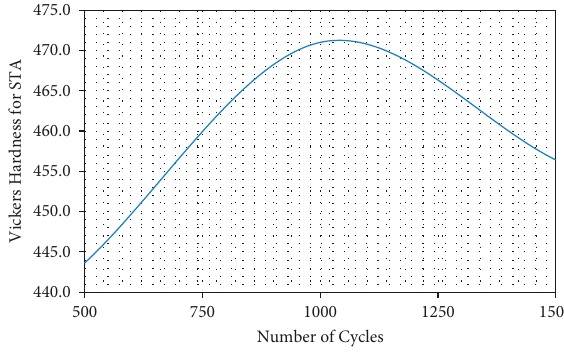
Figure 16: Vickers hardness of